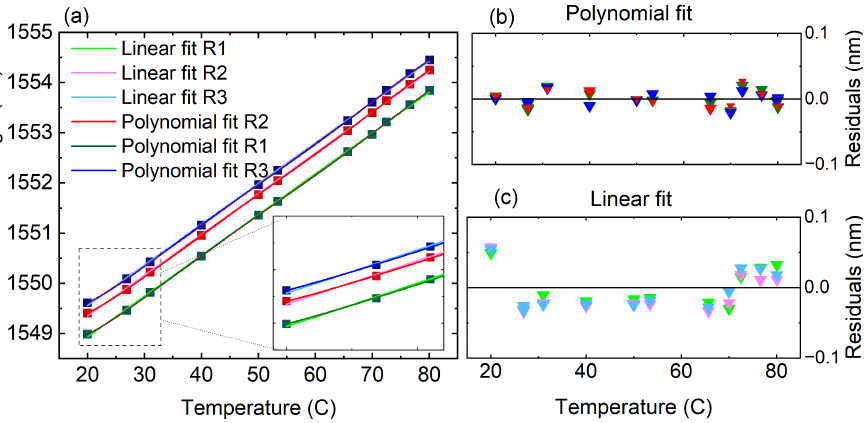
Figure 4. ( a ) Sensitivity of three different silicon ring resonators with radius of R1 = 35.048µm, R2 = 35.149µm and R3 = 35.037µm and gap of 470nm, 485nm and 500nm between the waveguide and resonator, respectively. Residuals of ( b ) linear fit, and ( c ) 4th degree Polynomial